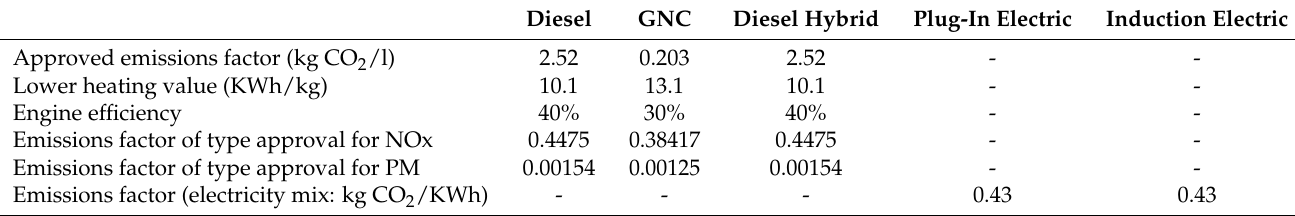
Table 11. Performance and emissions factors by type of fuel.